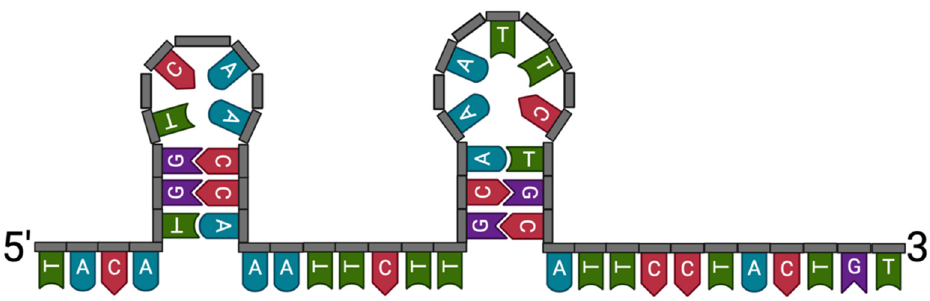
Figure 2. Secondary structure of Aci49 using UNAFold Δ G = − 4.15 at 21